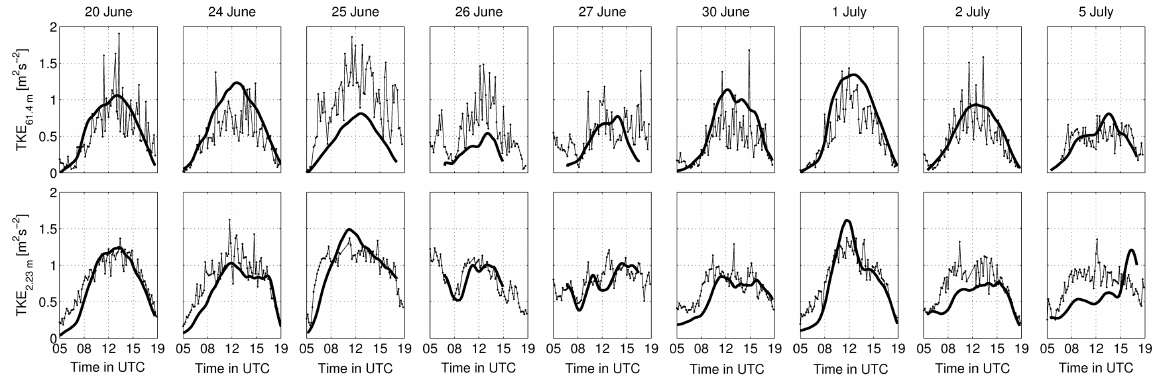
Figure 10. The lower row shows the modeled TKE interpolated to 2.23m (full lines) and observations (thin lines with dots). The upper row shows TKE at the 61.4m